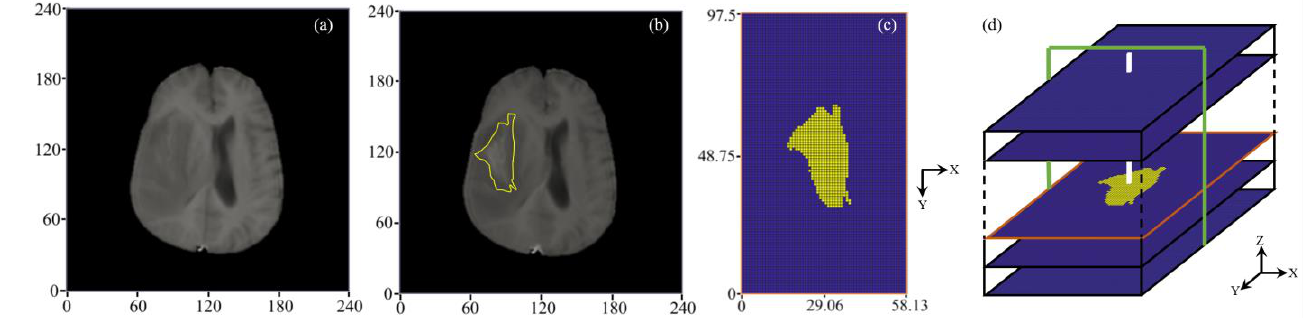
Figure 2. Model geometry. ( a ) Pre-contrast, and ( b ) post-contrast MR image of a representative slice with a yellow outline showing tumor boundary. ( c ) The segmentation result, along with CFD mesh where the tumor and its holding tissue are marked in yellow and blue, respectively. ( d ) Schematical diagram showing the 3D geometry reconstruction. Drugs are infused through the catheter marked in white color. Modelling results will be presented in the X-Z plane along the catheter track in the following sections, marked in green color.